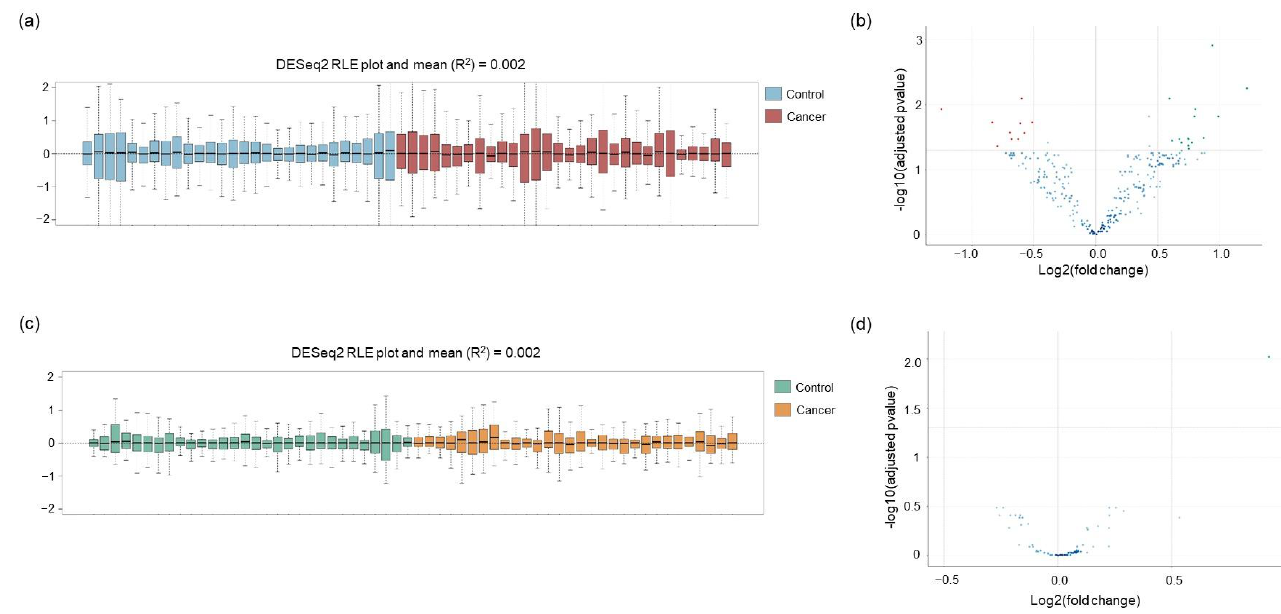
Figure 4. Normalization and differential expression analysis of mRNA and circRNA. ( a ) RLE plot of the normalized mRNA data generated using DESeq2. ( b ) Volcano plot of differentially expressed mRNAs. The negative log of the adjusted p -value (base 10) is plotted on the Y-axis, and the log of the FC (base 2) is plotted on the X -axis. Red dots indicate significantly downregulated mRNA and green dots represent significantly upregulated mRNA (adjusted p -value < 0.05). ( c ) RLE plot of the normalized circRNA data generated using DESeq2. ( d ) Volcano plot of differentially expressed circRNAs. Green dot represents the significantly upregulated circRNA (adjusted p -value < 0.05).